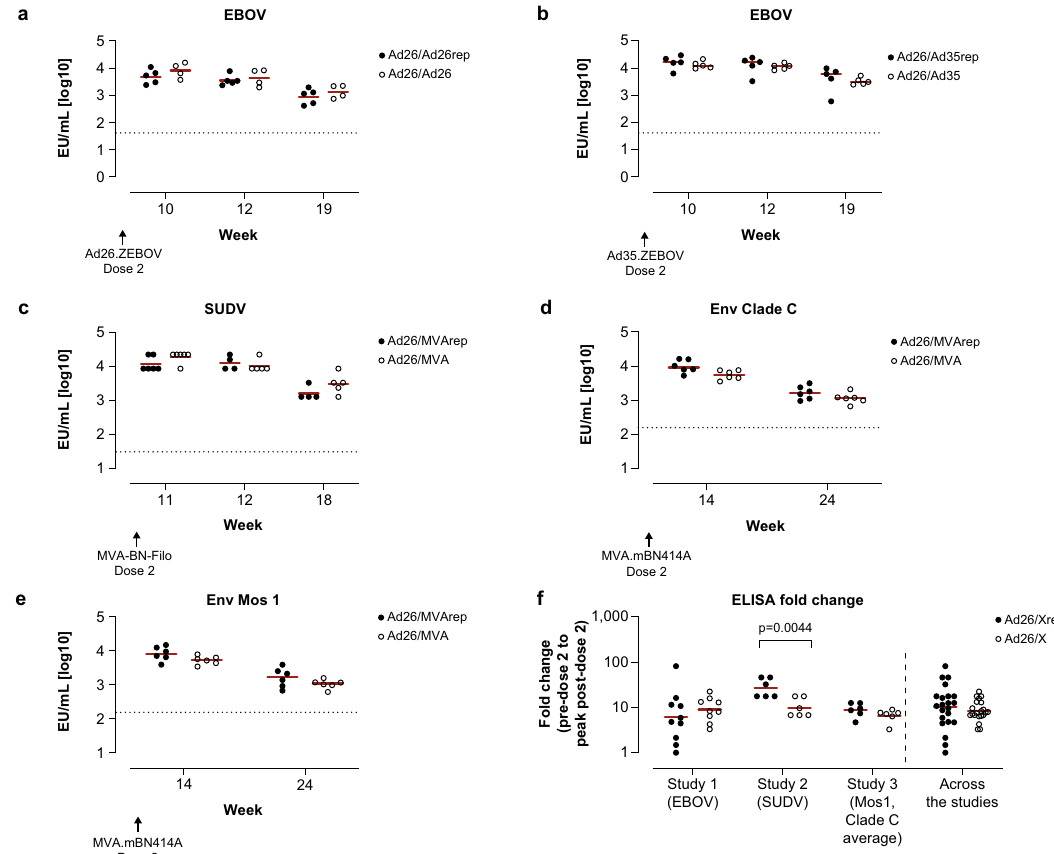
Fig. 6 Heterologous vectors boost Ad26 vaccine – induced humoral immune responses in the presence of pre-existing Ad26 immunity in cynomolgus macaques. Binding serum antibody concentrations were measured by ELISA for each regimen speci fi c for EBOV GP ( a , b ), SUDV GP ( c ), HIV Clade C Env ( d ), and HIV Mos1 Env ( e ), as described in the Fig. 4 legend. Shown are geometric group means of the log10 EU/mL values determined relative to an assay standard. Dotted lines represent the LLoD/LLoQ. For ( a , b ), the LLoQ of the human assay of 1.62log10 was used. For ( c ), the LLoD was de fi ned as 1.48log10 (EU/mL), measured for the pre-dosing samples in the SUDV GP – speci fi c assay 36 . For ( d , e ), the LLoQ of the human assay of 2.19log10 was used, whereas the ULoQ of the human assay was 3.69log10 31 . The fold-change in antibody concentrations is depictured in ( f ) and corresponds to the change in response comparing pre – dose 2 to peak response post – dose 2 per animal. Ad26/Xrep refers to animals vaccinated in the A-series, and Ad26/X refers to animals that were not vaccinated during the A-series. The red horizonal line is the geometric mean. Pairwise comparison of the difference between pre-exposed animals and unexposed animals per time point was performed for data in ( a – e ), summarized in Supplementary Table 2. An ANOVA was performed over the fold-changes per study and across the 3 studies over the data shown in ( d ), summarized in Supplementary Table